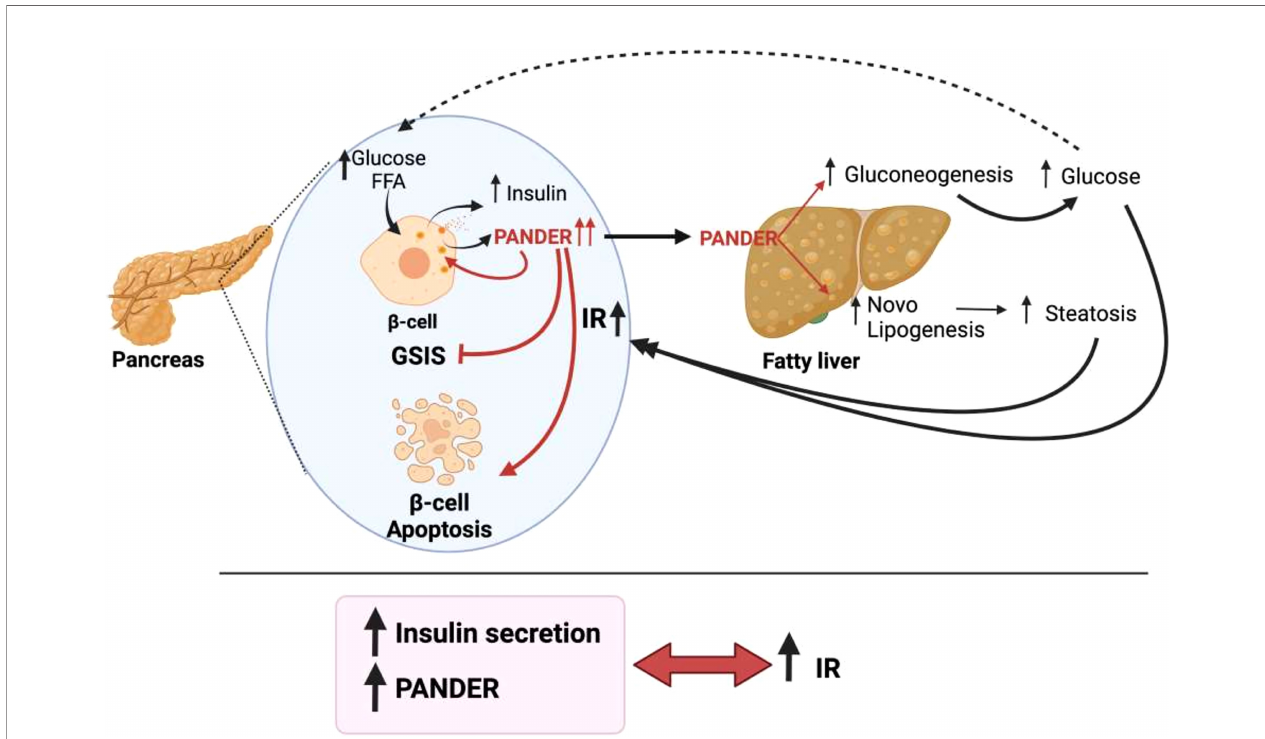
FIGURE 2 | Pancreatic derived factor (PANDER) is the only word used by pancreatic b -cells to communicate with the liver. In the presence of nutrients, PANDER is co-secreted with insulin and acts to regulate insulin release. When IR is present, b -cells increase insulin and PANDER release. In this situation, the increase in PANDER induces b -cell apoptosis and a decrease in GSIS. In addition, PANDER travels to the liver, binds to its receptors on hepatocyte membranes and leads to increased gluconeogenesis and steatosis.